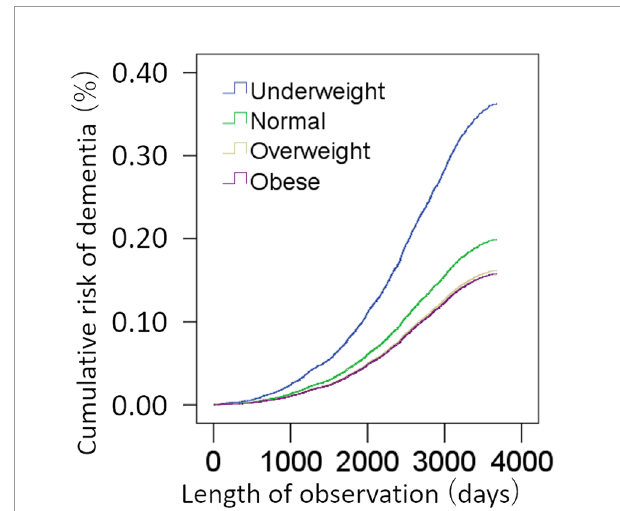
confounding variables.